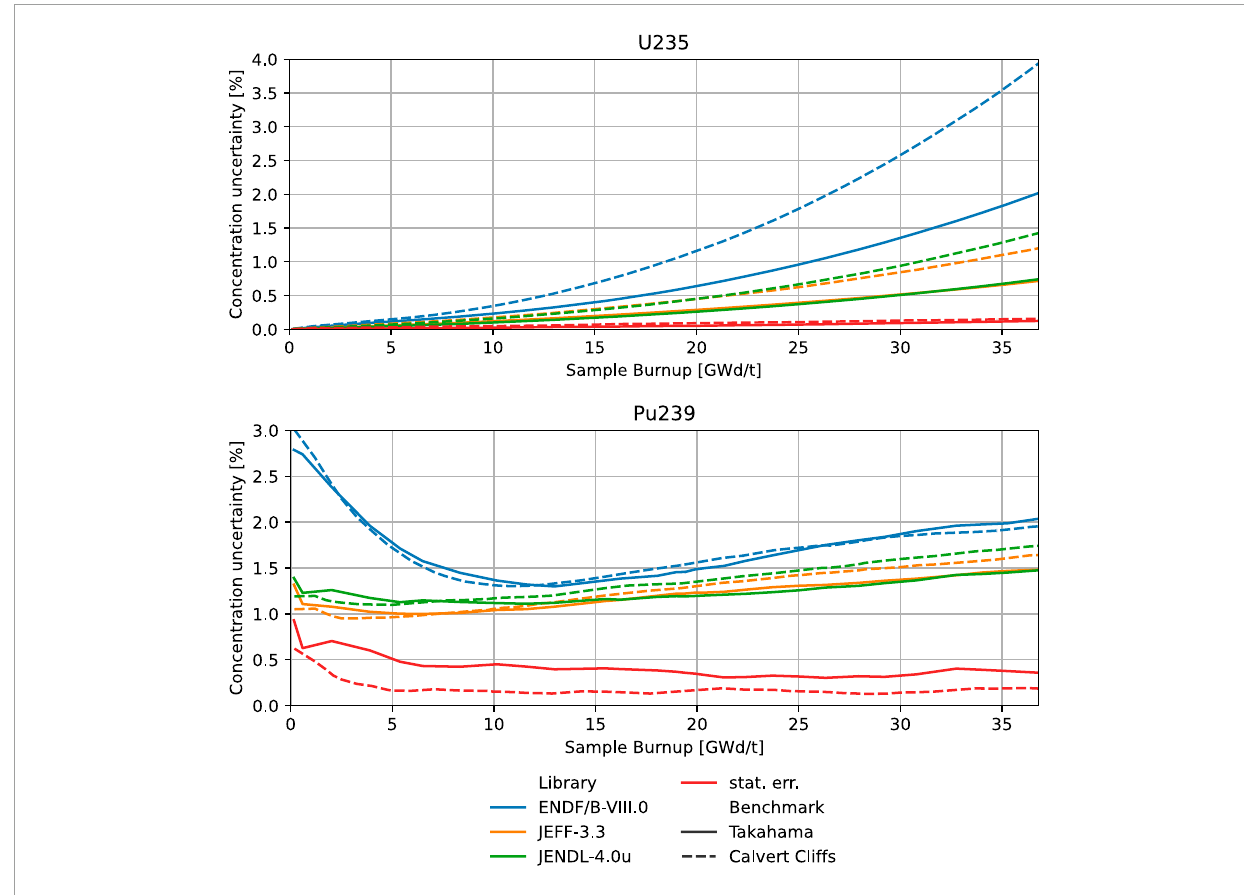
FIGURE 10 Concentration uncertainty evolution with burnup for nuclides 235 U (top) and 239 Pu (bottom).